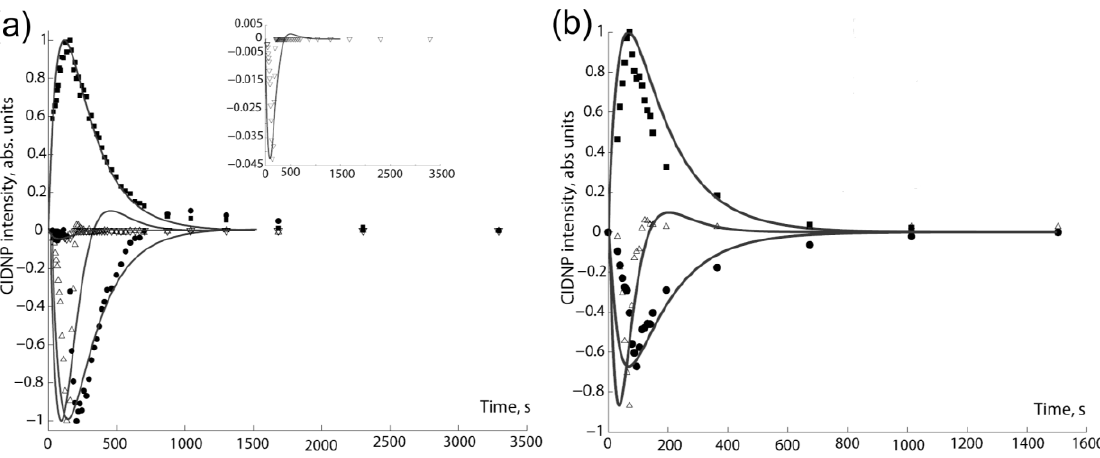
Figure 2. Kinetics of polarized signals (normalized) during thermolysis of 0.02 M solution of alkoxyamines in FSol 2a (a) at 386 K in the presence of 3 eq. of thiophenol and 3a (a) at 386 K in m -C D Cl in the presence of 6 eq of thiophenol: ( ■)—alkoxyamine 2a 6 4 2